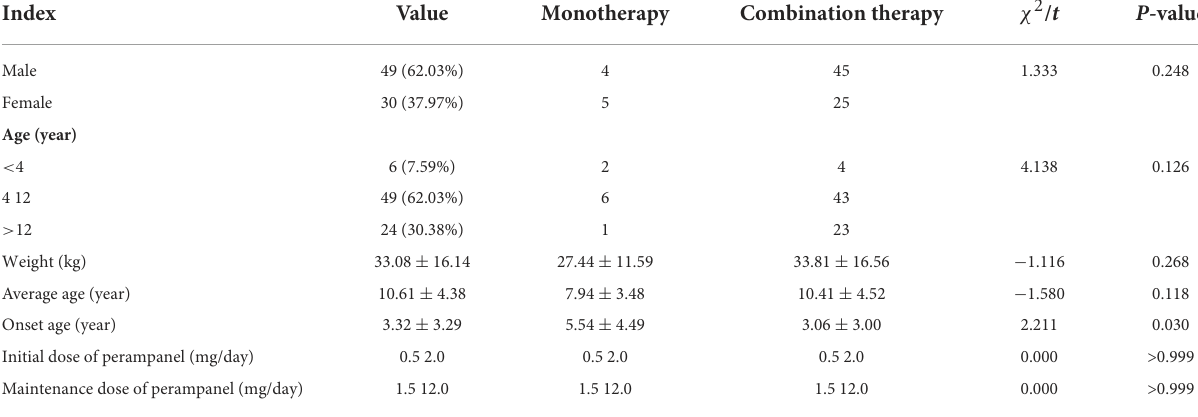
TABLE 1 General information of patients.